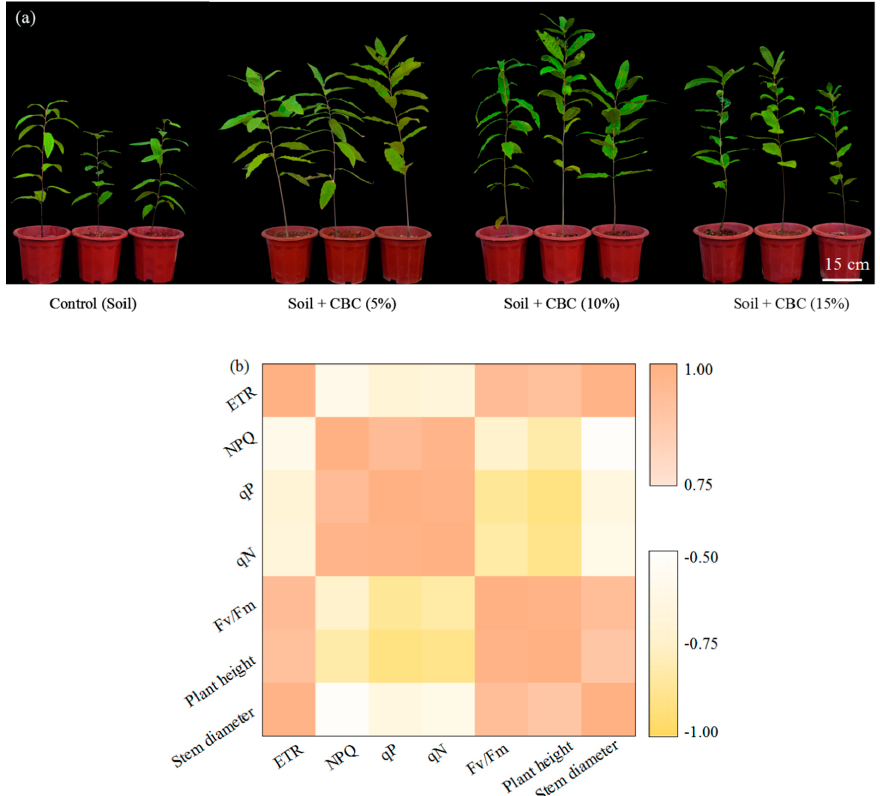
Figure 6. Growth of chestnut plants with different dosages of CBC addition ( a ), and the Pearson correlation matrix ( b ) between the fluorescence parameters and chestnut plant biomass (CBC: chestnut burrs compost, ETR: Electron transport rate, NPQ: non-photochemicalquenchingcoefficient, qP: photochemical quenching, qN: non-photochemical quenching, Fv/Fm: maximum efficiency of photochemical quenching, qN: non-photochemical quenching, Fv / Fm: maximum e ffi ciency of PSII photochemistry under